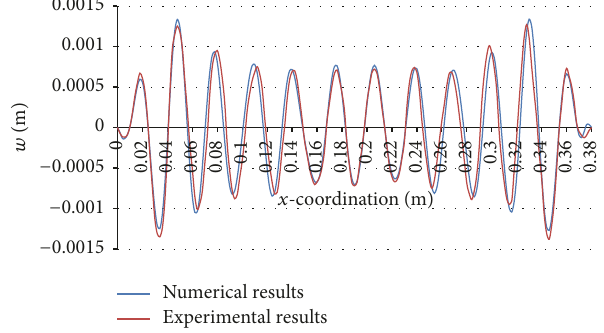
Numerical results Experimental results